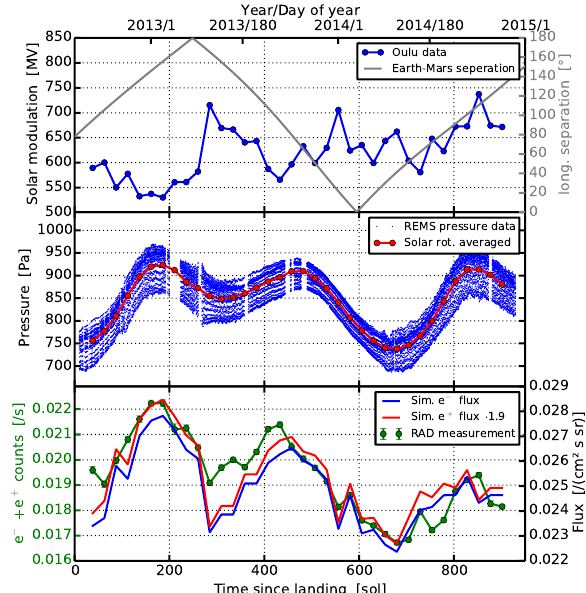
Figure 7. Top: solar modulation calculated from Oulu data (blue) and Earth-Mars longitudinal separation (gray). Middle: REMS pres- sure data. Bottom: RAD 4–20MeV electron + positron count rate (green) and Planetocosmics prediction for 4–20MeV electron and positron fluxes (blue, green). To minimize the influence of the so- lar rotation, the measurements and Planetocosmics predictions have been averaged over one solar rotation. The non-averaged REMS data show huge variations, which are caused by the diurnal varia-